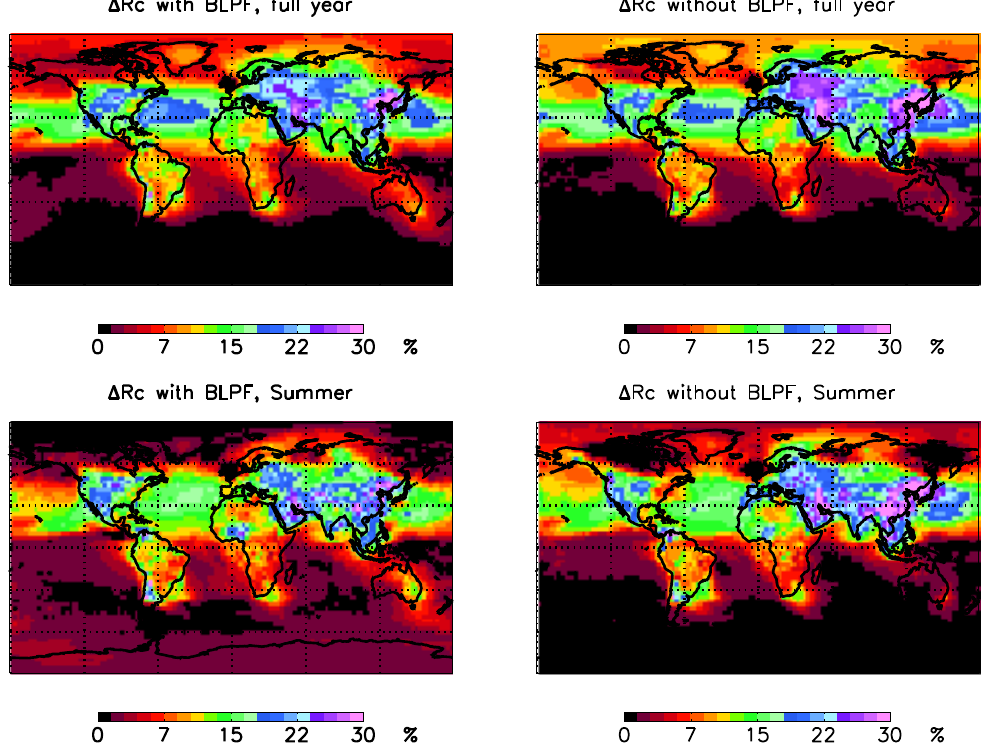
Fig. 13. The 1850–2000 change in cloud albedo with and without boundary layer particle formation (BLPF) at 300–1000 m above ground level, as predicted with GLOMAP. Results are shown for an initial albedo R c =0.35 assuming cloud updraft velocity w =0.4ms − 1 (published in Merikanto et al.,